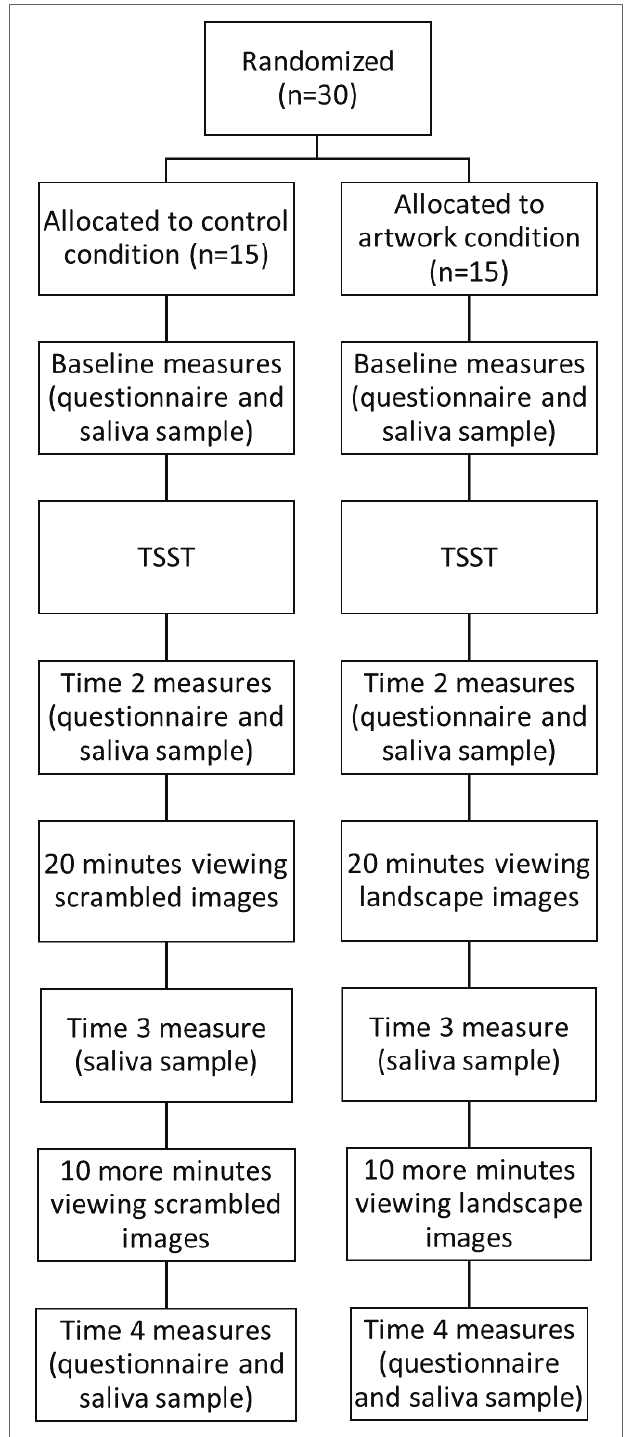
FIGURE 1 | Flow chart showing the procedure of the